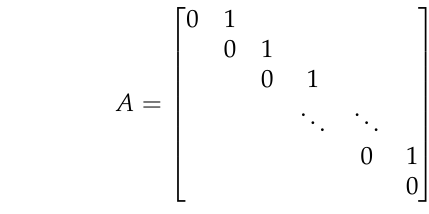
Figure 1. A directed graph G and its adjacency matrix A .